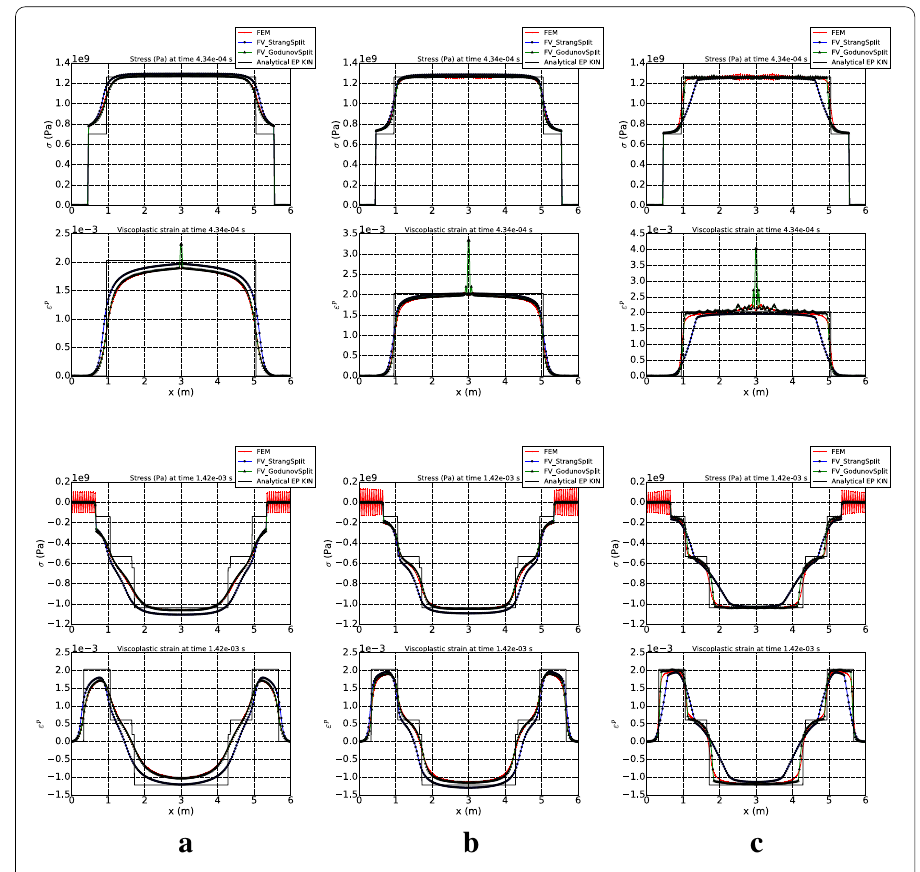
Fig. 5 Comparison for different values of the relaxation time τ , between the elastic–viscoplastic finite element (FEM), finite volume (FV) with Strang and Godunov splitting numerical solutions and the elastic–plastic analytical solution. Comparison is performed on axial stress and viscoplastic strain fields at two different times. a τ = 10 − 4 s. b τ = 4 . 8 × 10 − 6 s. c τ = 10 − 7